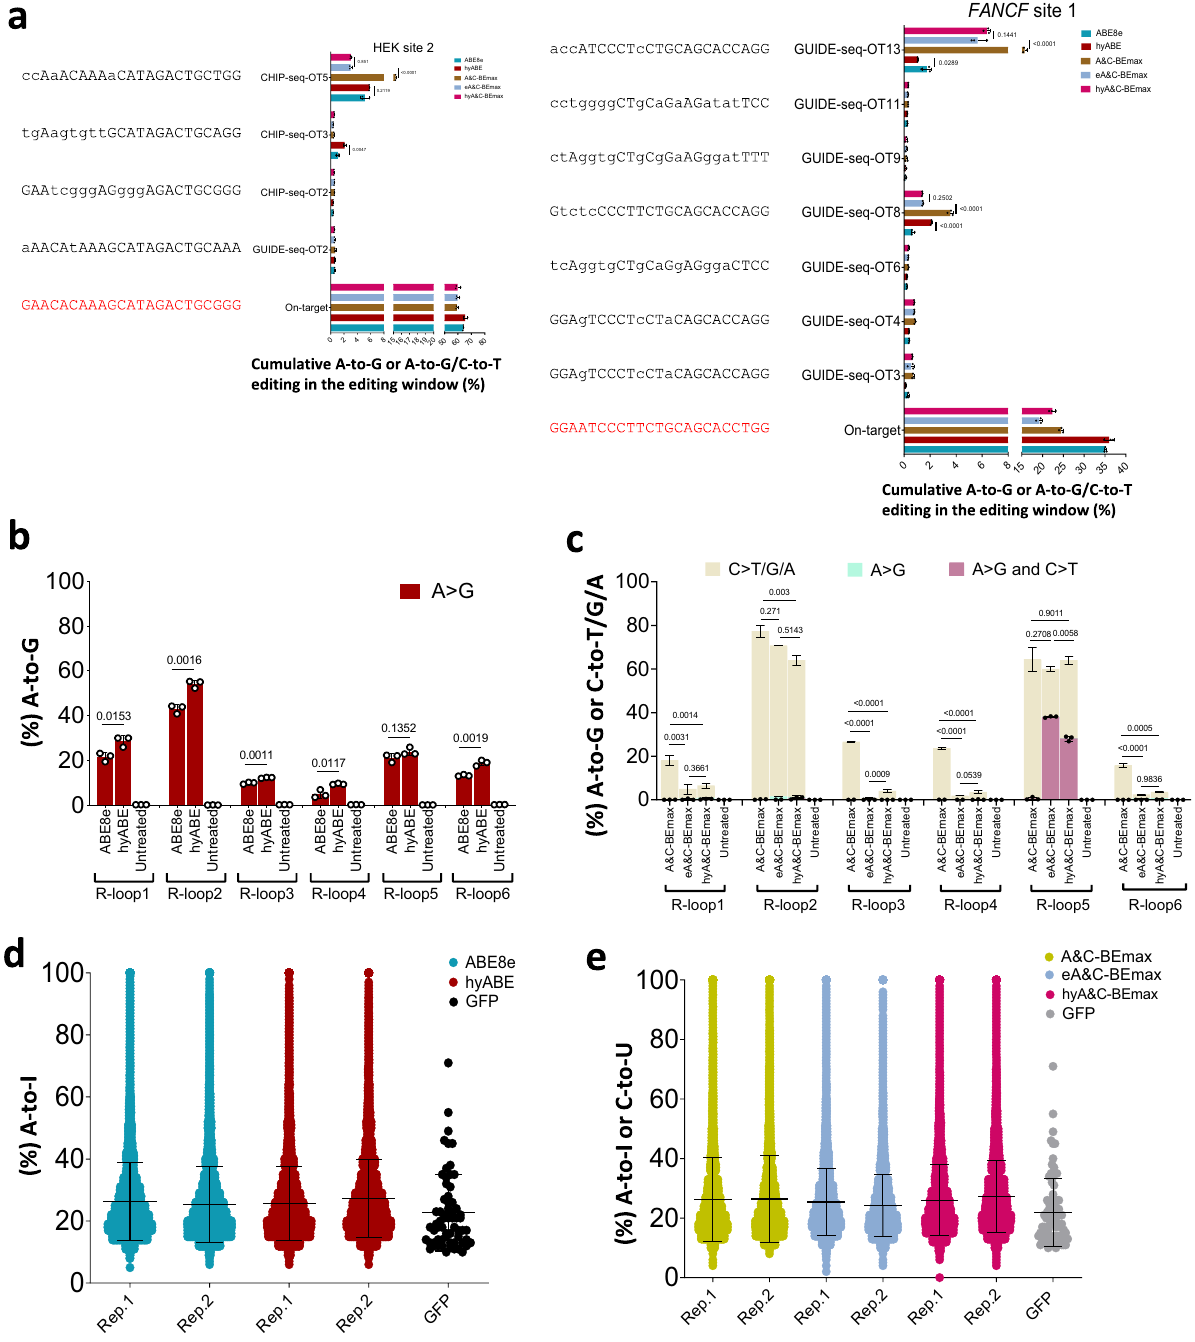
Fig. 3 | Off-target assessments of hyper ABE and hyper A&C-BEmax. a Cas9- dependent DNA on and off-target analysis of the indicated targets (HEK site 2 and FANCF site 1) by ABE8e, hyABE, A&C-BEmax, eA&C-BEmax and hyA&C-BEmax in HEK293T cells. Lowercase protospacer sequences represent mismatched bases compared to their corresponding on-target sequences. Data are means±SD ( n =3 independent experiments). b , c Cas9-independent DNA off-target analysis of